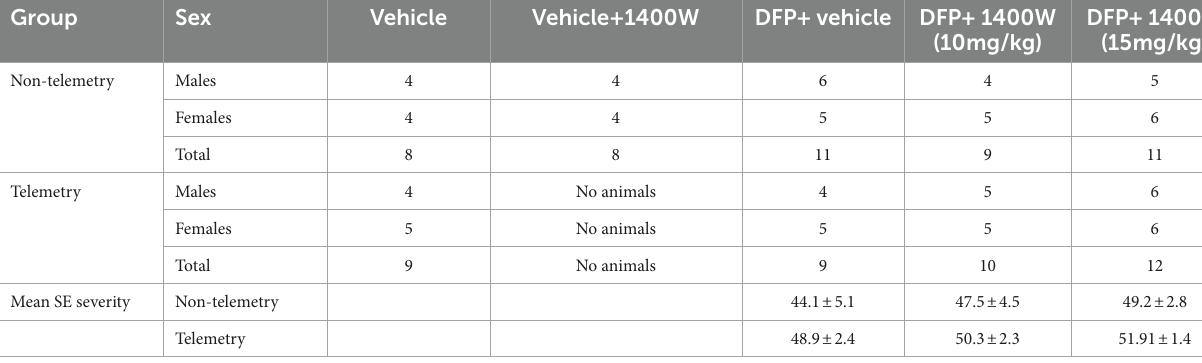
TABLE 1 Animal numbers in different groups and mean SE severity.